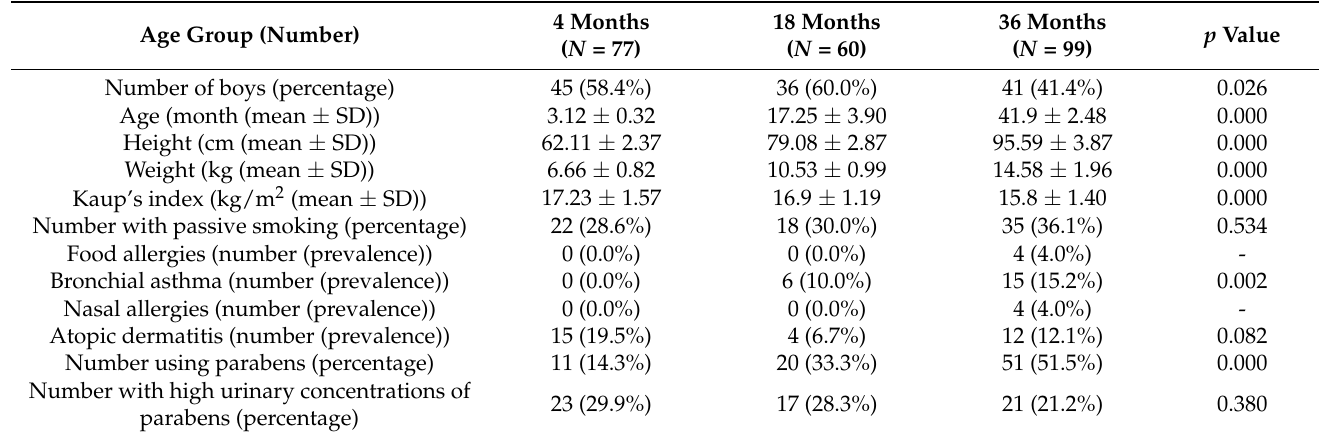
Table 2. Prevalence of allergic diseases and other factors according to age groups.